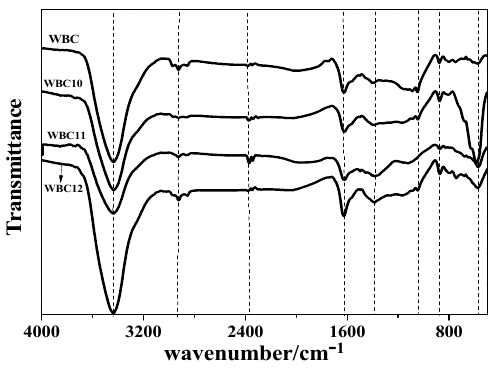
Figure 6. Fourier transform infrared (TIR) spectra of WBC and WBC1x.